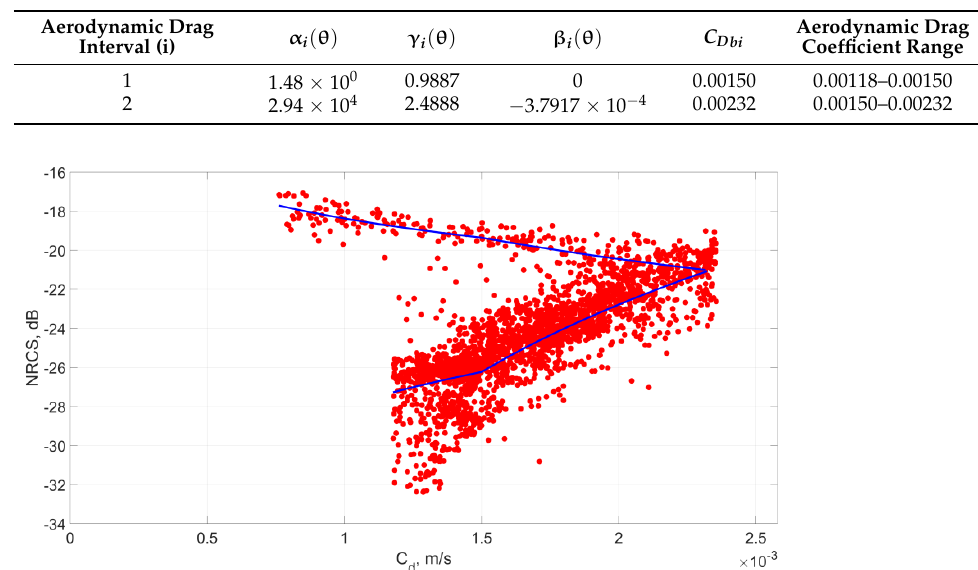
Table 6. The MADP-S1 power approximation coefficients for the aerodynamic drag coefficient retrieval (NRCS with the values less than 0.0079 ( − 21.4 dB)).